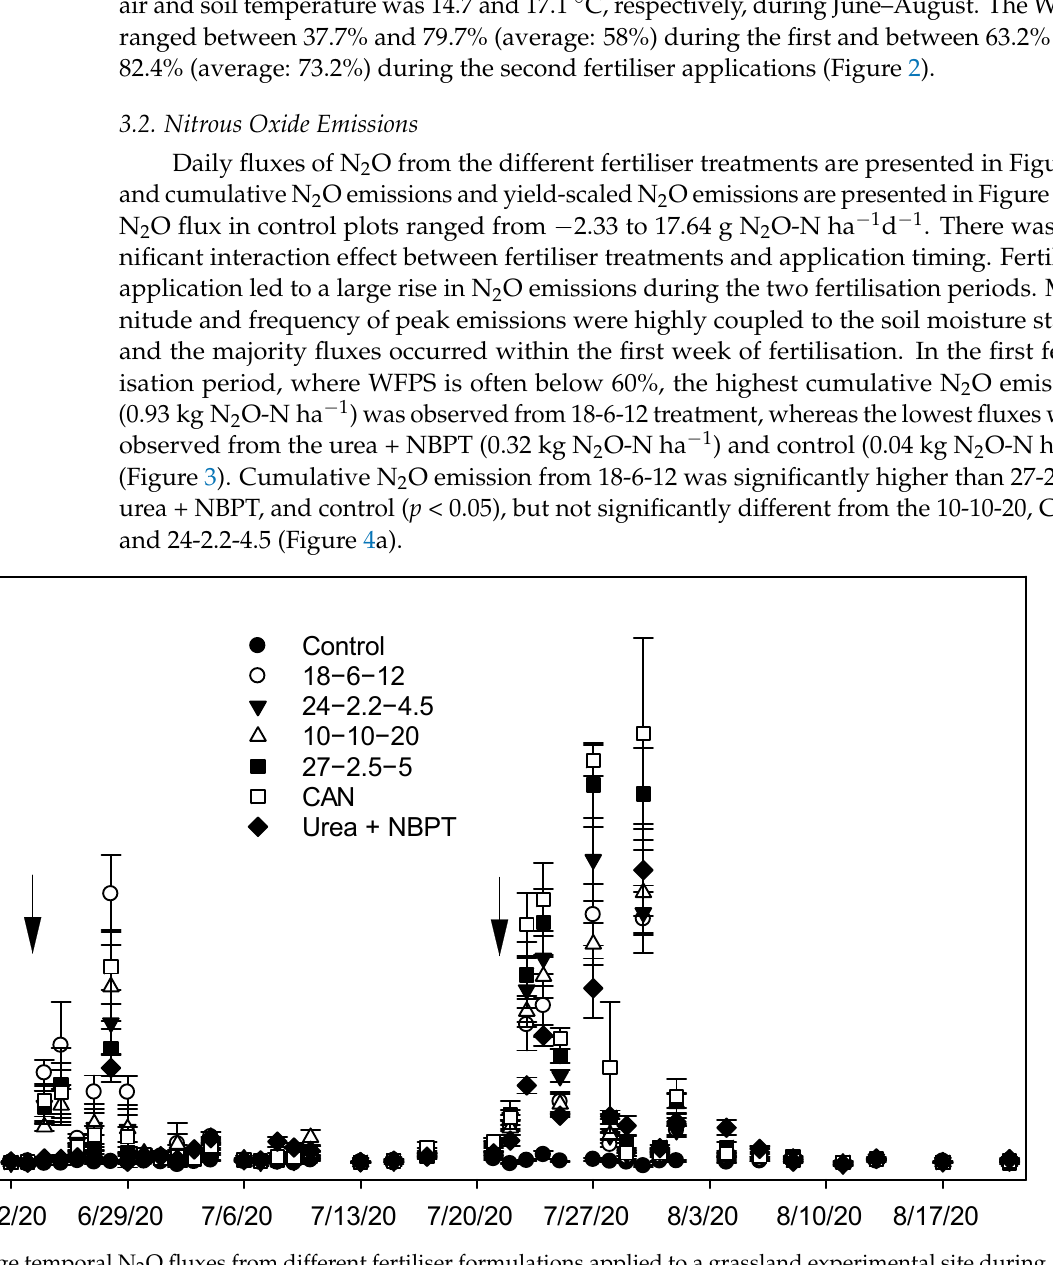
Figure 3. Average temporal N 2 O fluxes from different fertiliser formulations applied to a grassland experimental site during a growing season. Arrows indicate applications dates of fertilisers.